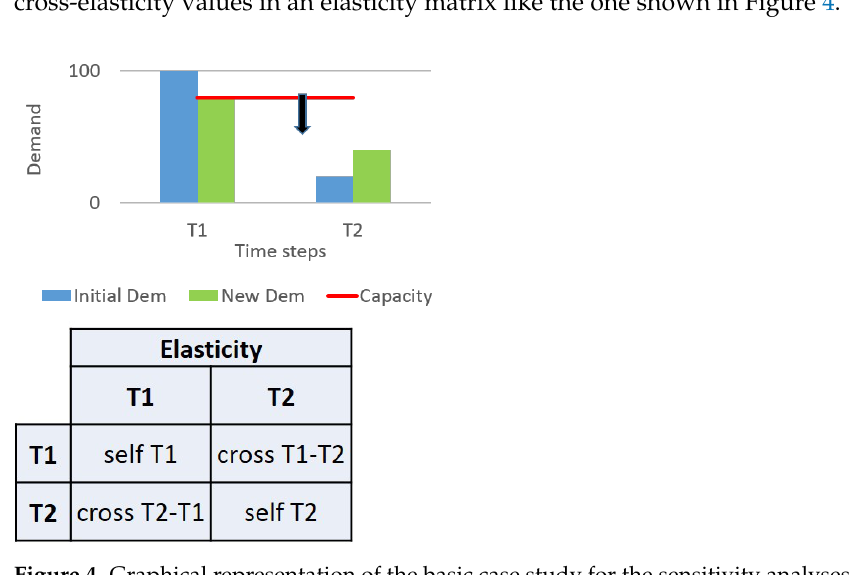
Figure 4. Graphical representation of the basic case study for the sensitivity